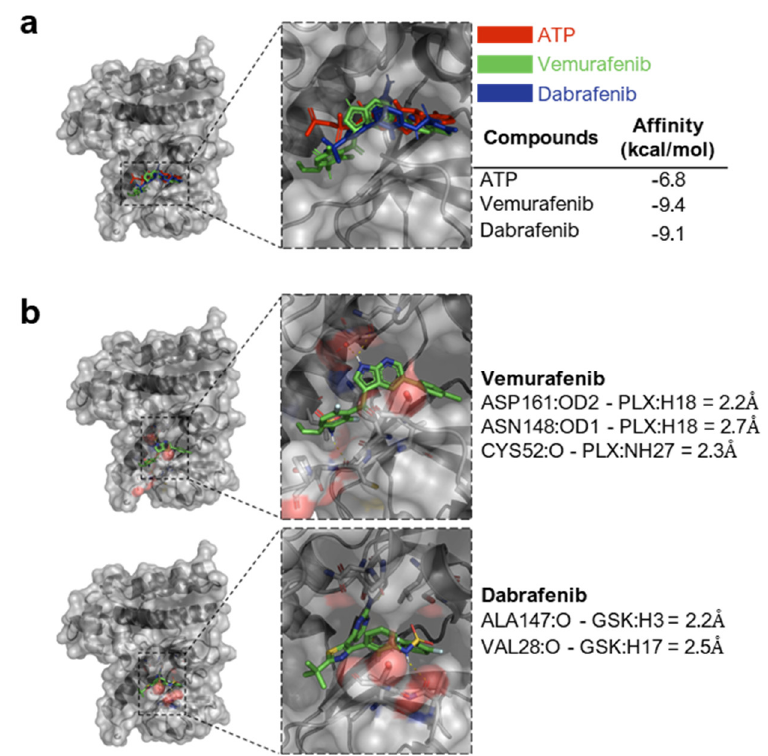
Figure 5. Inhibitors of the BRAF V600 protein can directly interact with the RIPK4 kinase. ( a ) Molecular docking of ATP, vemurafenib, and dabrafenib binding to RIPK4. RIPK4 was shown in cartoon style (with Connolly surface), while the analyzed ligand was shown in the stick model. The energy of affinity for vemurafenib, dabrafenib, and ATP to RIPK4 is −9.4; −9.1; −6.8 kcal/mol, respectively, for these inhibitors. ( b ) Potential hydrogen bonds between the RIPK4 ligand molecule and the protein.